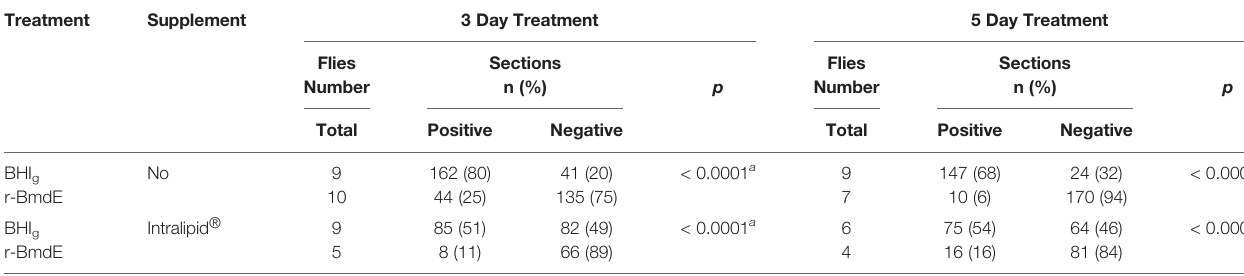
TABLE 2 | In vivo effect of r-BmdE treatment on P. acnes bio fi lm. Treatment